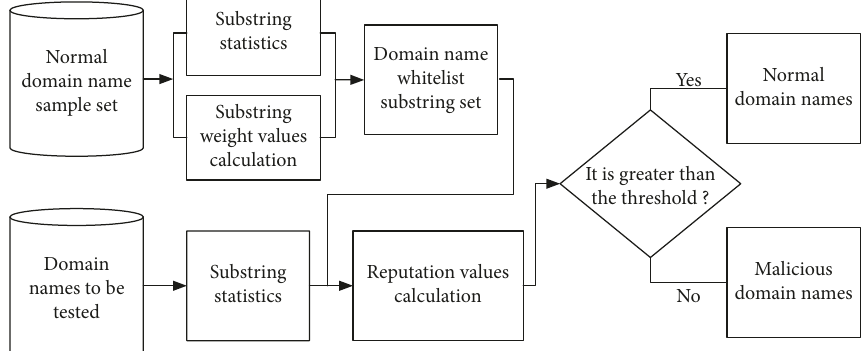
Figure 1: Flowchart of malicious domain names detection algorithm based on N -Gram.